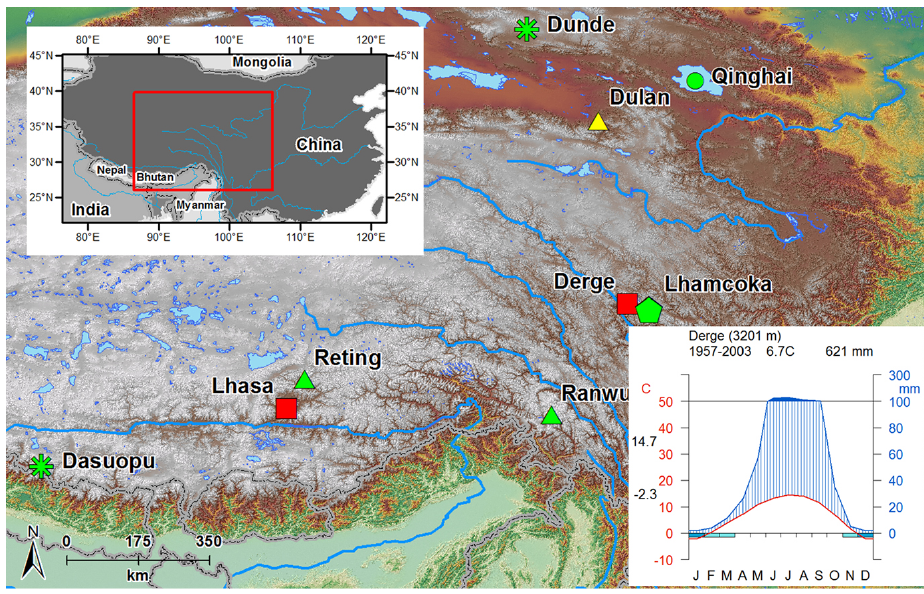
Figure 1. Location of the study site Lhamcoka (green pentagon) and other proxy archives mentioned in the text. Green triangles: tree- ring δ 18 O chronologies; yellow triangle: tree-ring width chronology; green asterisk: ice cores; green circle: lake sediments. Red rectangles indicate climate